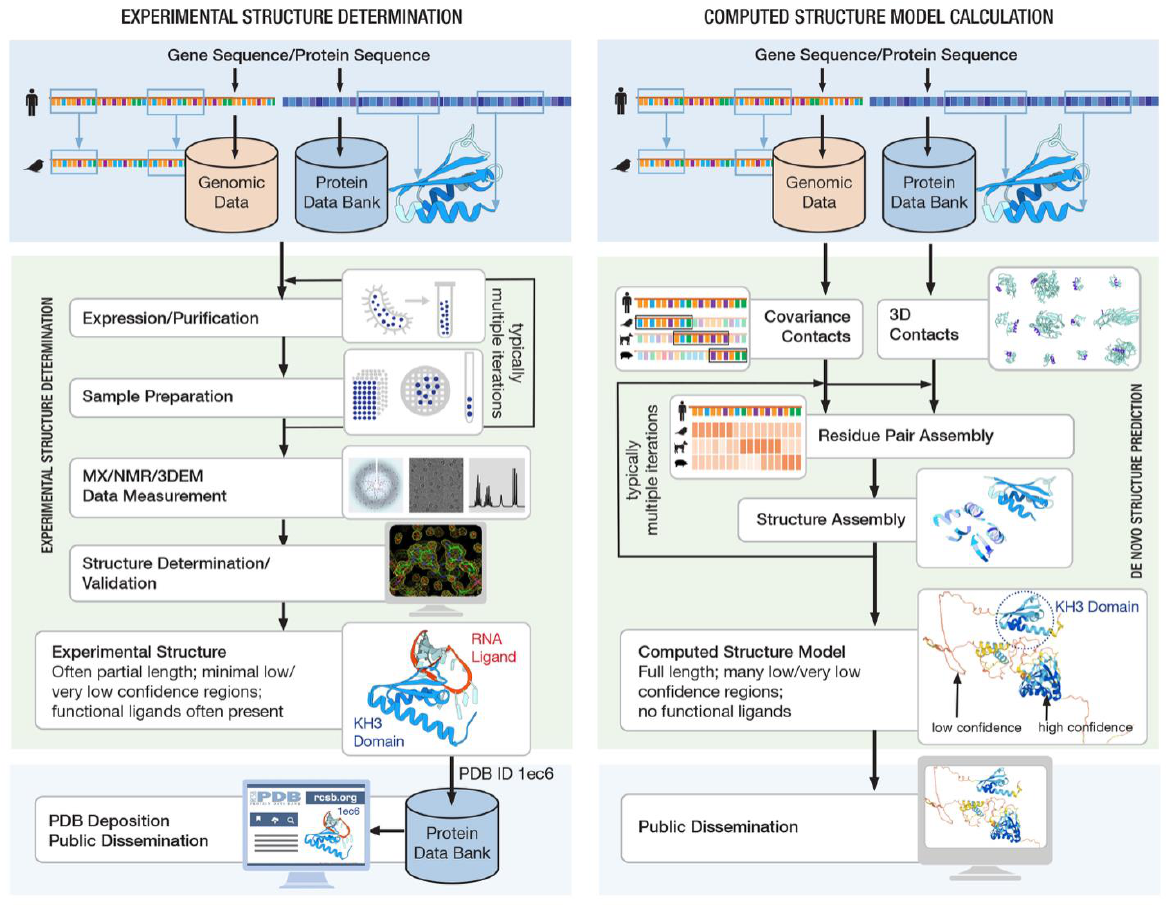
Figure 10. Experimental approaches for determination of protein structures and computational methods for predicting structures both rely on open access to genomic and 3D structure data. Here, methods for determining the structure of the RNA-binding protein Nova-2 are shown. The MX structure ( left ) was determined for an isolated domain of the protein bound to its RNA target. The computed structure ( right ) includes the entire polypeptide chain, which is predicted to include three well-folded domains (blue/cyan) connected by apparently unstructured linkers (yellow/orange). Image adapted from New England Journal of Medicine , Stephen K. Burley, Wadih Arap, Renata Pasqualini, Predicting Proteome-Scale Protein Structure with Artificial Intelligence, 385, 2191 – 2194 [173] .Copyright © 2022 Massachusetts Medical Society. Reprinted with permission.